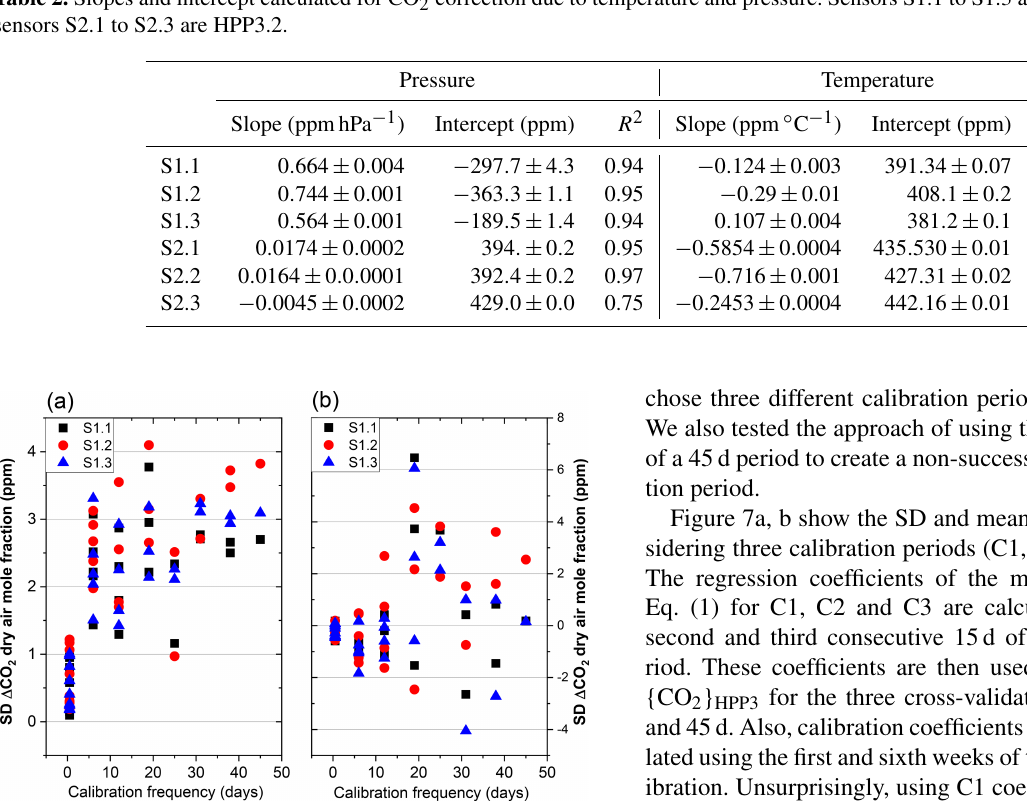
Figure 6. SD (a) and mean (b) values of the 1min average of mean (cid:49) {CO 2 }, during a measurement period of 48d depending on the calibration